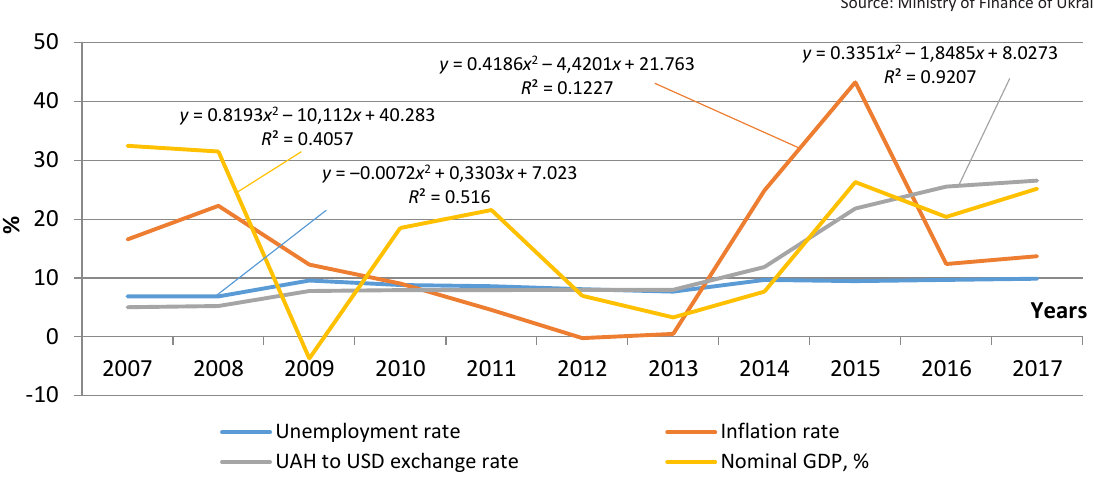
Source: Ministry of Finance of